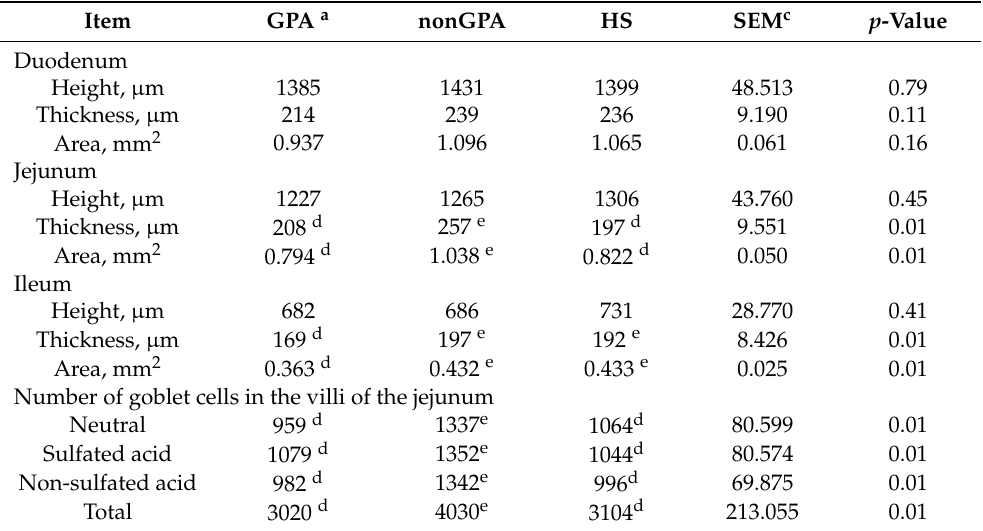
Table 4. Effect of the type of growth promoter on the villus histology and goblet cell number at day 28 a,b . Item GPA a nonGPA HS SEM c